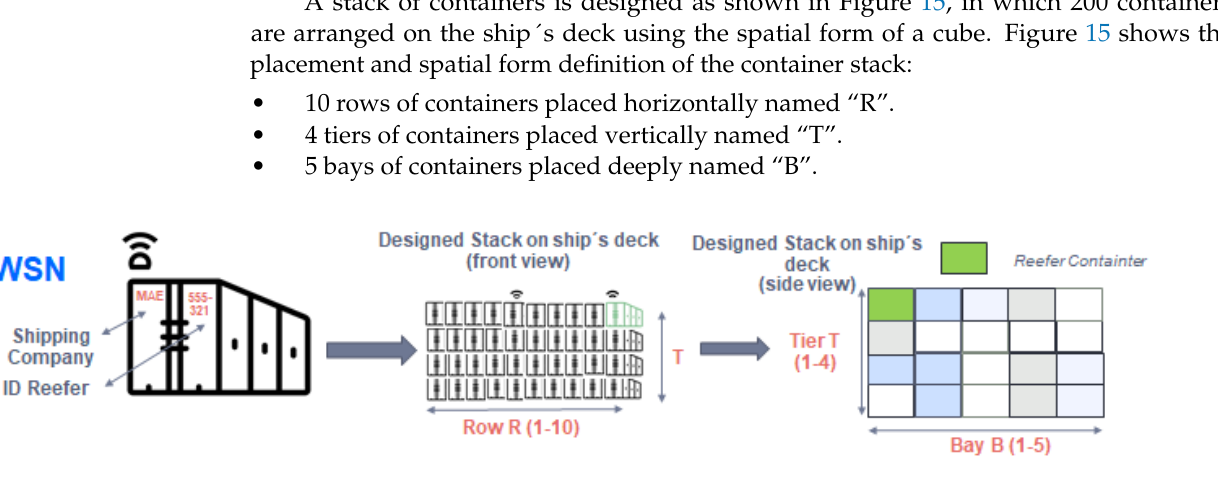
Figure 15. Design of a container stack with the spatial location of the monitored reefer